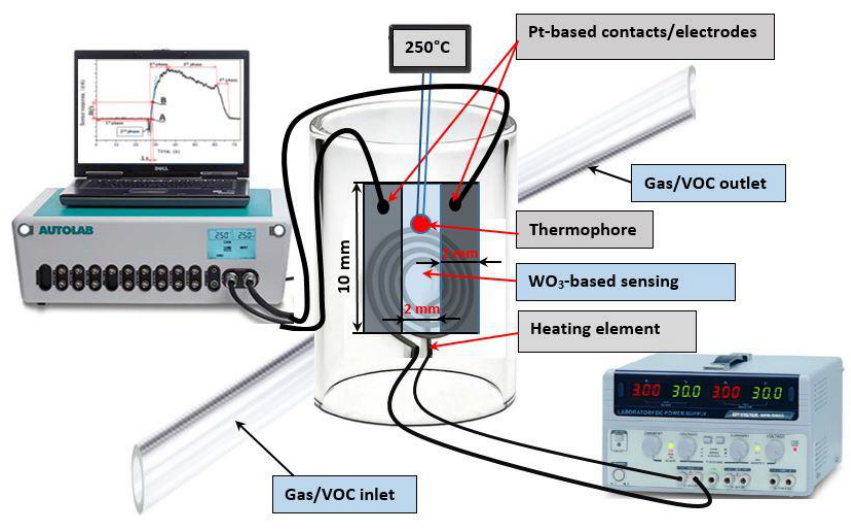
Figure 1. Major parts of experimental setup and structure of WO 3 /WO 3−x -based sensor.